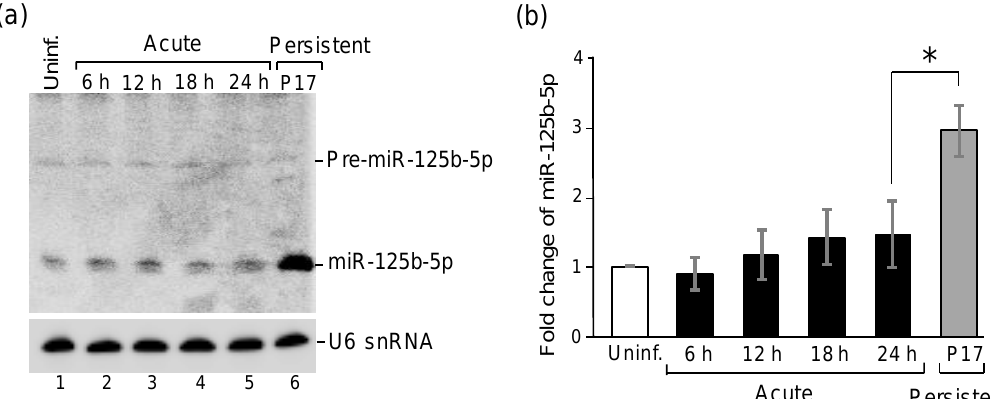
Figure 1. MiR-125b-5p is highly expressed in persistently JEV-infected cells. ( a ) Northern blot analysis of miR-125b-5p expression. Total RNAs were extracted from uninfected BHK-21 cells (lane 1), cells infected with JEV RP-9 at an MOI of 0.1 at the indicated times post-infection (hpi), and persistently infected cells at passage 17 (P17). Northern blot analysis was done using in vitro transcribed radiolabeled riboprobe specific to miR-125b-5p. The positions of precursor miR-125b-5p (pre-miR-125b-5p), mature miR-125b-5p (miR-125b-5p), and U6 snRNA are indicated. ( b ) The same RNAs were subjected to RT-qPCR analysis to determine the expression of miR-125b-5p. The relative fold change was normalized to endogenous U6 snRNA. Bars represent the mean ± SD ( n = 3). *: p -value < 0.05 comparison between acute (24 hpi) and persistent infection (P17) was analyzed by Student’s t -test.